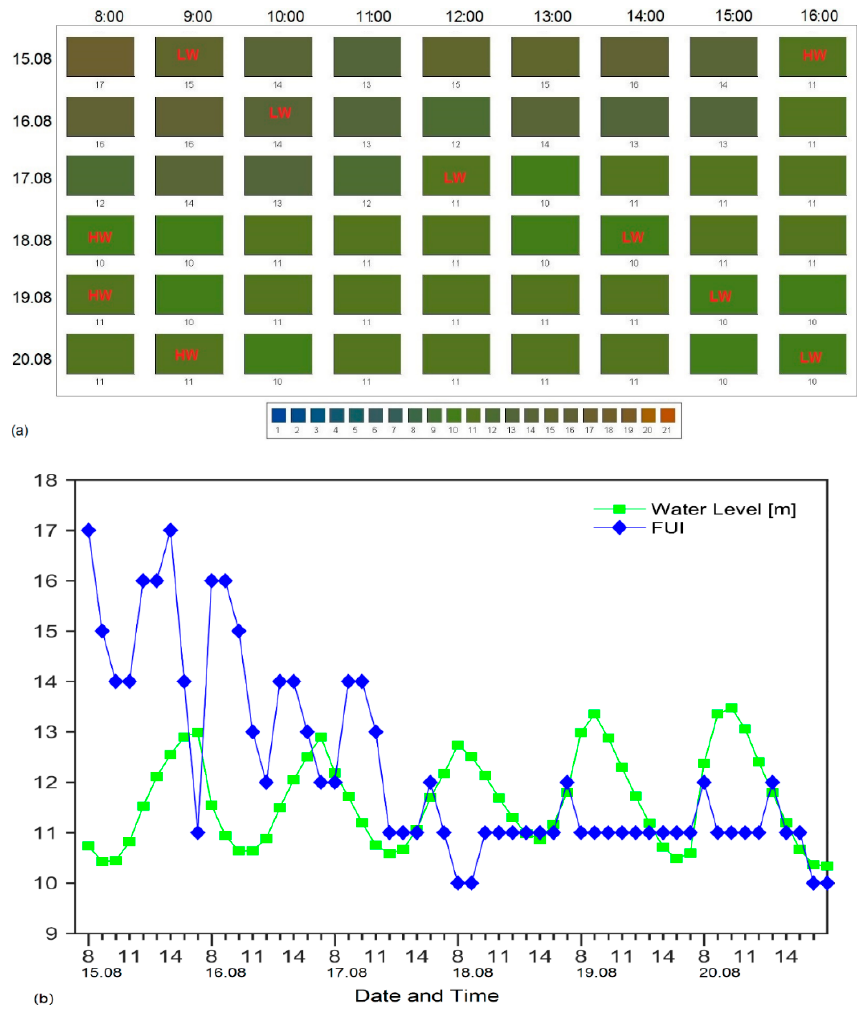
Figure 5. ( a ) Hourly averaged changes in Forel-Ule Index (FUI) colour of water and ( b ) hourly averaged water level and FUI colour changes between 08:00 and 16:00 UTC, from 15 August to 20 August 2013 at the Wadden Sea time series station Spiekeroog. HW indicates high water level and LW indicates low water level.